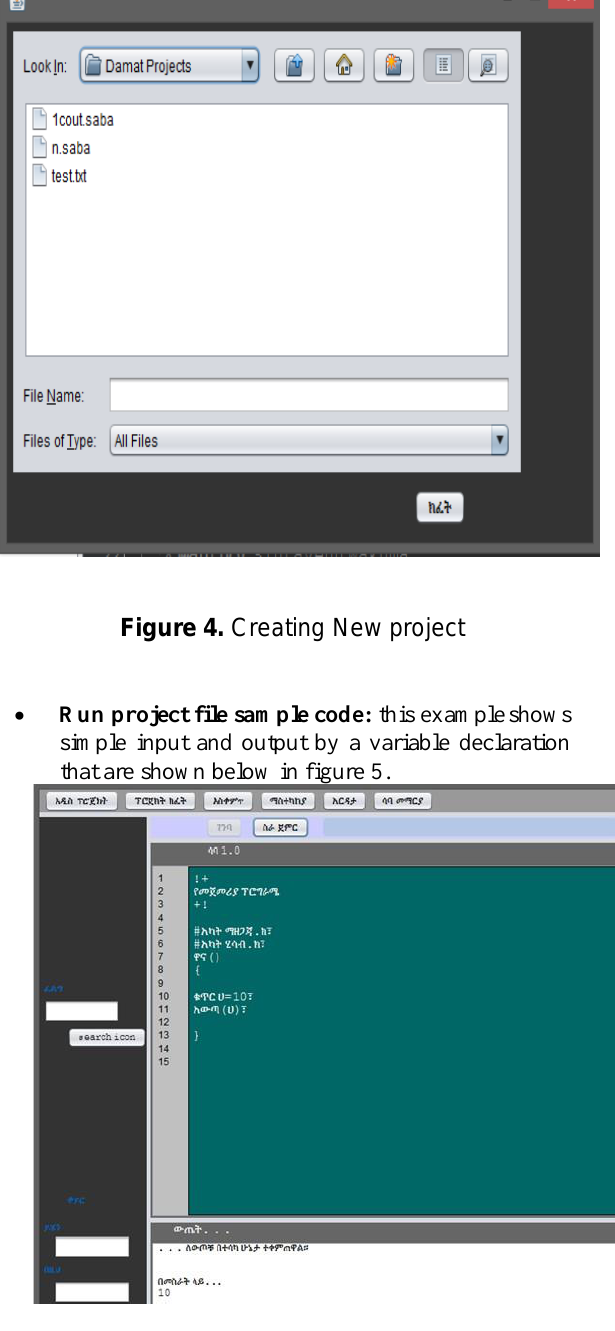
Figure 5. Displaying generated Output